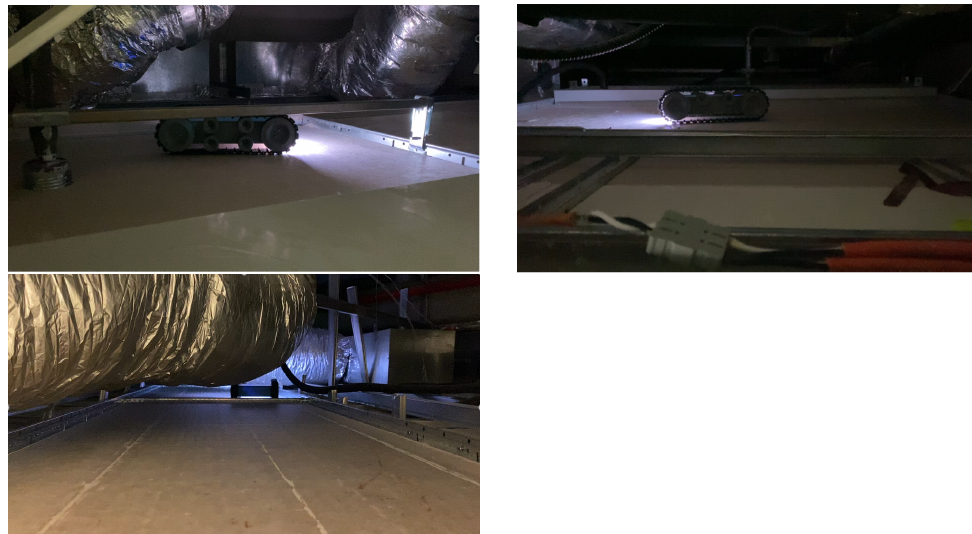
Figure 8. Falcon rodent activity inspection in a false ceiling environment.